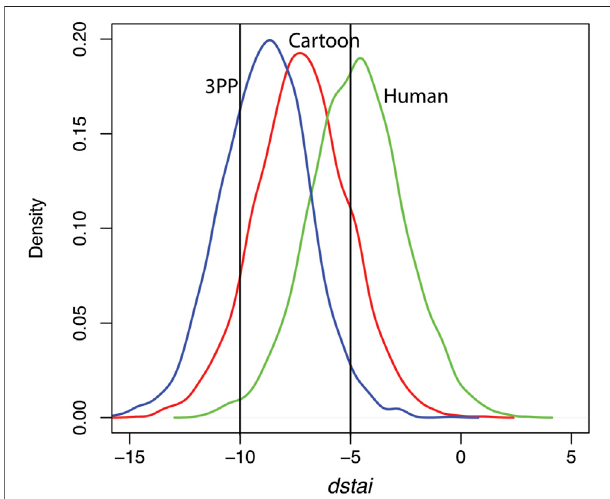
FIGURE4| Posteriordistributionsof dstai atthemeanlevelof staitrait for the Cartoon, Human and 3PP conditions.